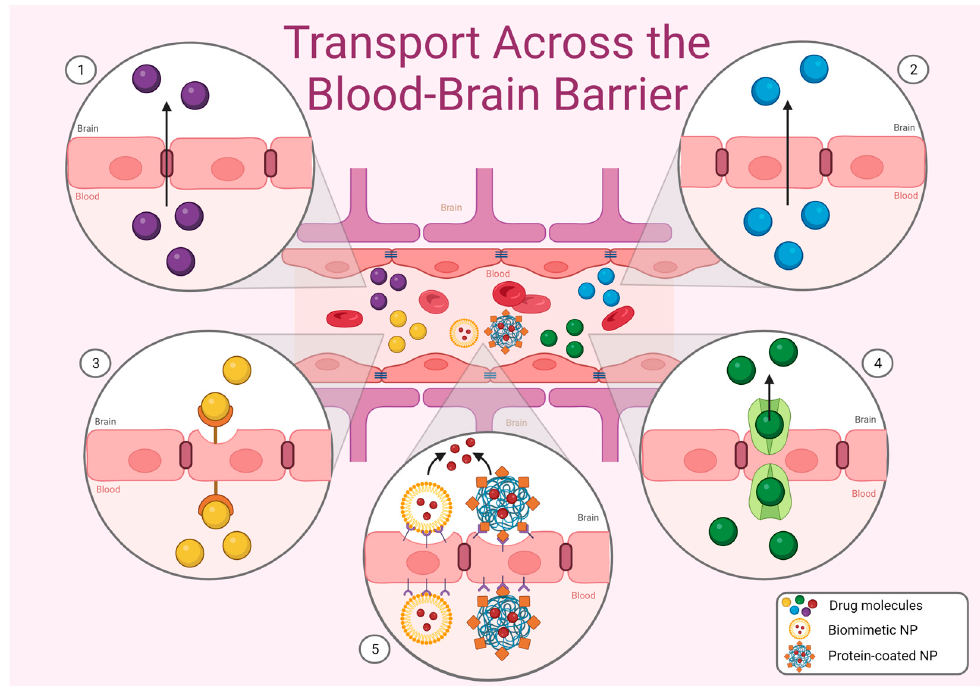
Figure 1. Transport across the BBB primarily occurs by paracellular transport (1), passive diffusion (2), receptor-mediated transcytosis (3) or carrier-mediated transport (4). Nanoparticles (NPs) can also cross the BBB for CNS drug delivery (5); biomimetic NPs synthesized using physiological proteins, cell membranes and viruses take advantage of the natural uptake of these materials. Additionally, synthetic nanoparticles can be coated in targeting ligands such as transferrin, P-glycoprotein and angiopep-2 that bind to receptors located on BBB cells to facilitate permeation of the BBB and drug release within the brain parenchyma (Created in BioRender.com; accessed on 2 February 2023).